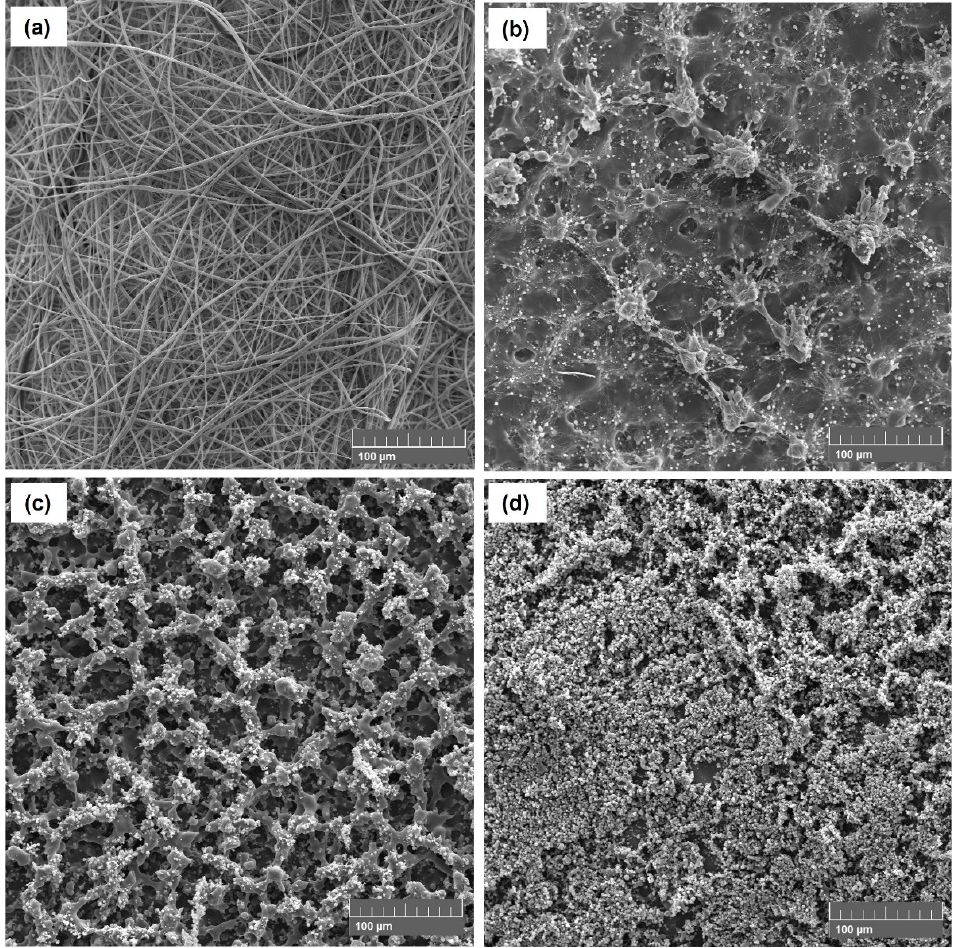
Figure 2. SEM images of spun A ( a ), sprayed A ( b ), sprayed B ( c ), and sprayed C solutions ( d ). Scale bar = 100 μ m.